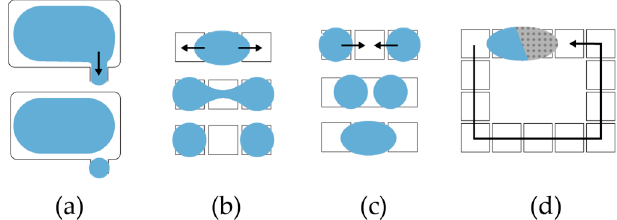
Figure 6. The microfluidic operations that can run on O PEN D ROP . The droplets are: ( a ) dispensed from reservoirs; ( b ) split; ( c ) merged and ( d ) mixed.